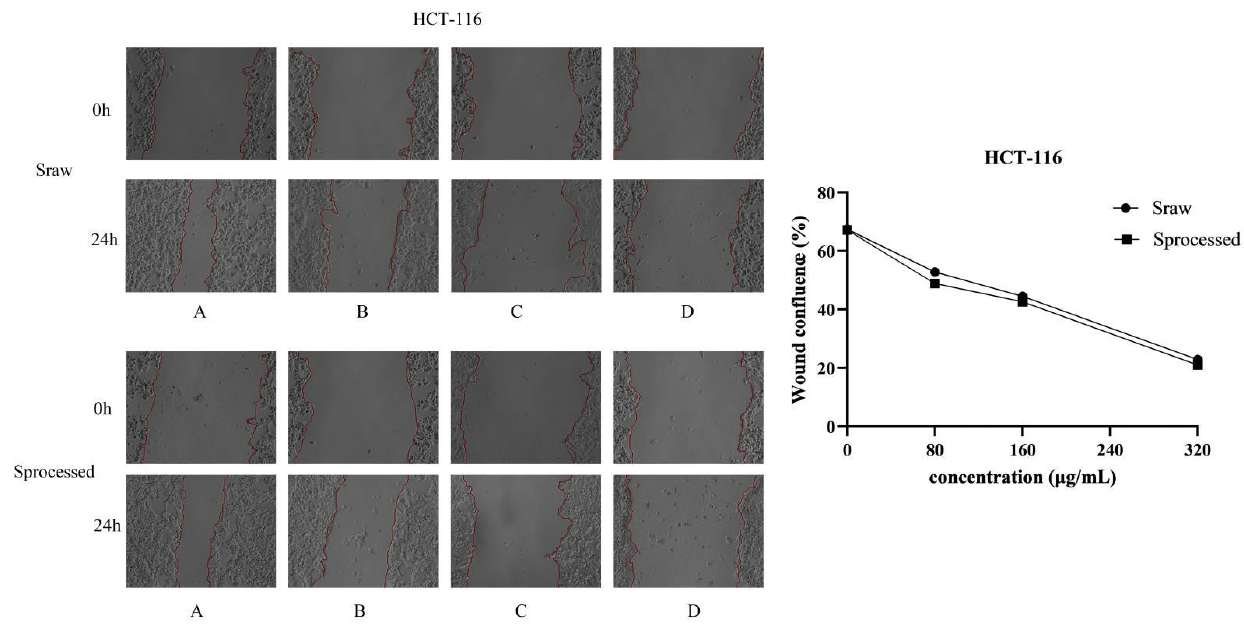
Figure 10. Wound healing assays in HCT116 cells showing inhibition by Sraw and Sprocessed (scratch analysis). A : 0 μg/mL ; B : 80 μg/mL ; C : 160 μg/mL ; D : 320 μg/mL.